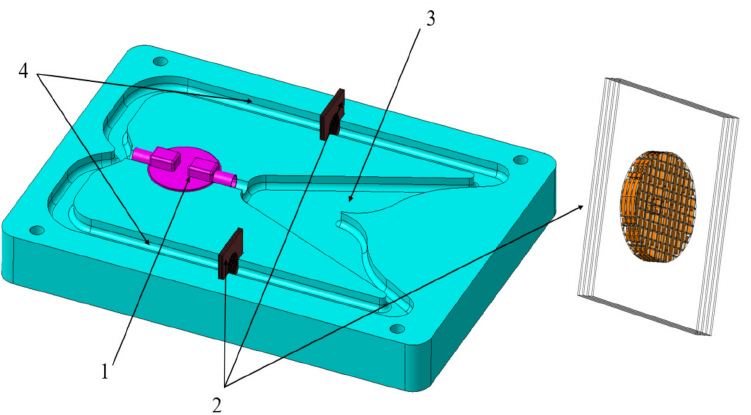
Figure 2. Configuration of the liquid jet gyroscope: 1. fluid pump; 2. electrochemical transducers; 3. jet chamber; 4. shunt channels.